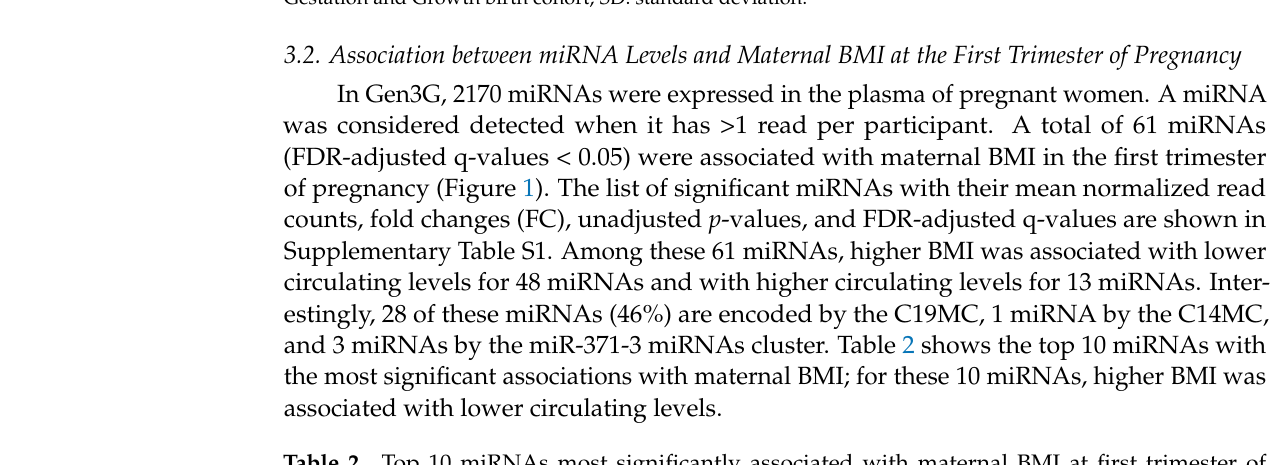
Table 2. Top 10 miRNAs most significantly associated with maternal BMI at first trimester of pregnancy in the Gen3G